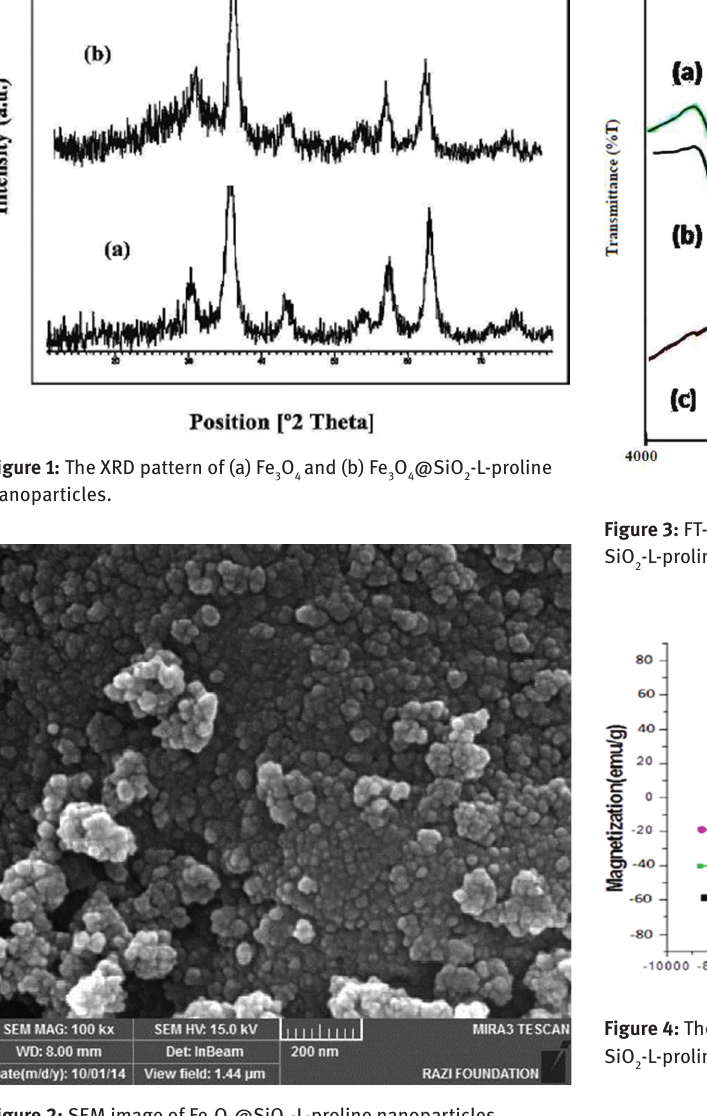
Figure 2: SEM image of Fe